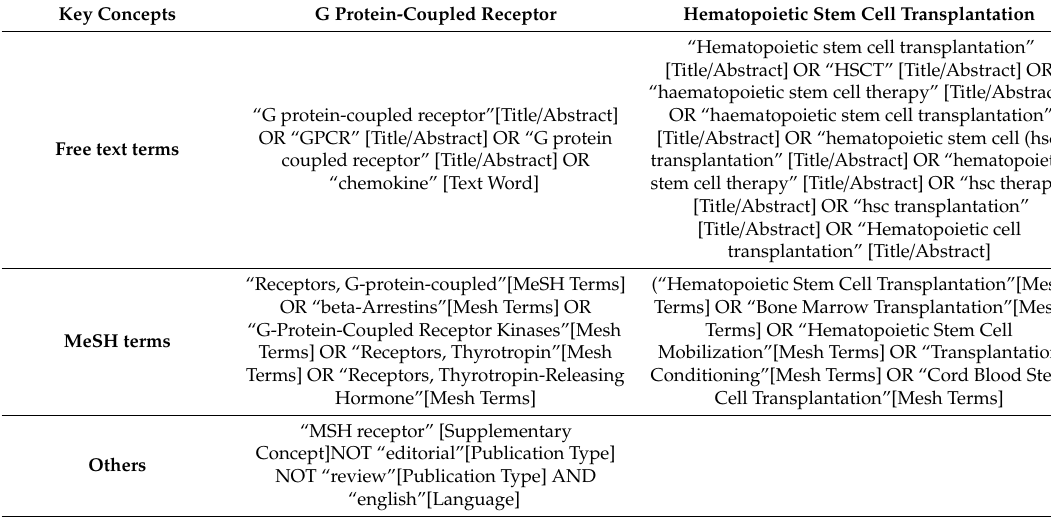
Table A1. Search equation built for MEDLINE (Pubmed